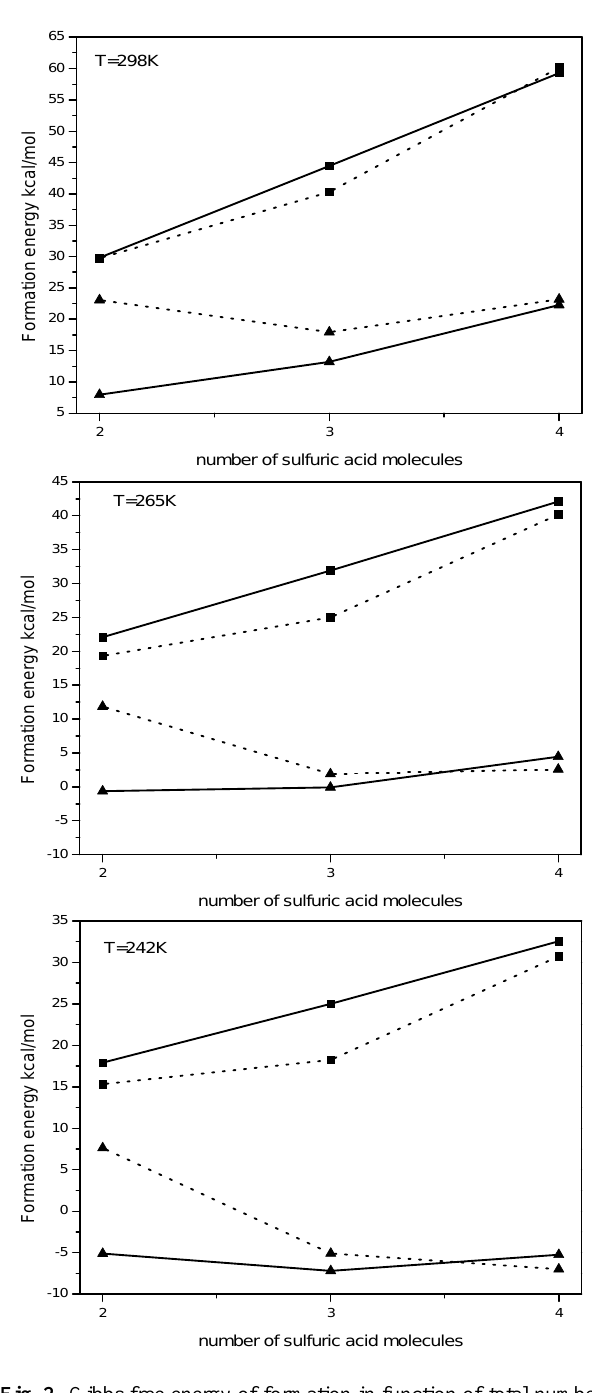
Fig. 2. Gibbs free energy of formation in function of total number of sulfuric acids in the cluster (neutral and charged), broken lines represent cluster with ammonia, solid lines represent cluster with- out ammonia, squares represent neutral clusters, triangles represent charged clusters. Upper panel: corresponds to upper troposphere ( 1G 1 )conditions, Middle panel corresponds to mid-troposphere ( 1G 2 ) conditions and Lower panel: corresponds to ground level ( 1G 3 ) conditions, Table 3 lists the temperature and vapor pressures used.